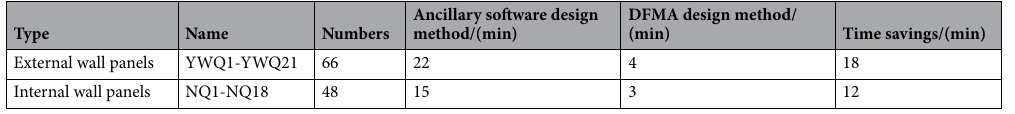
Table 2. Speed comparison of design